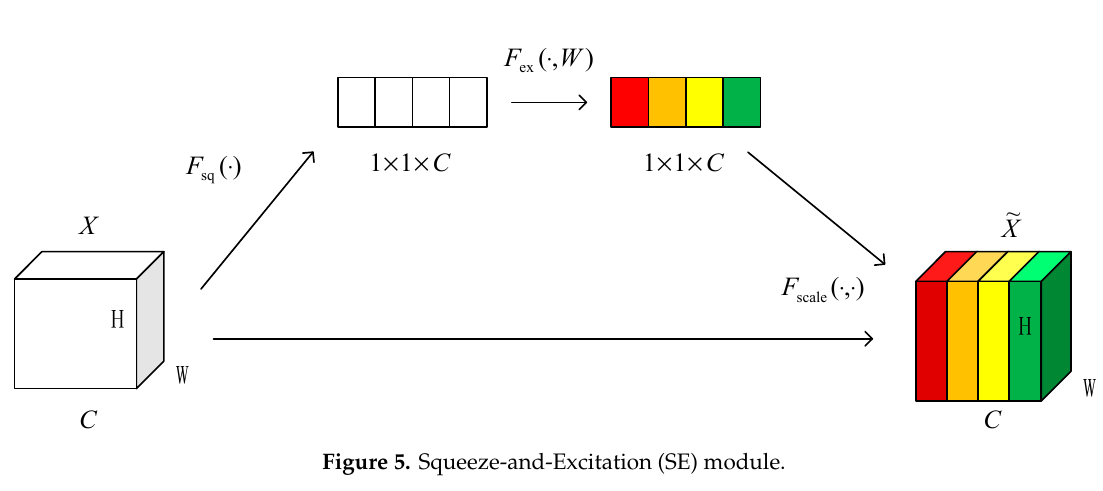
Figure 5. Squeeze-and-Excitation (SE) module.